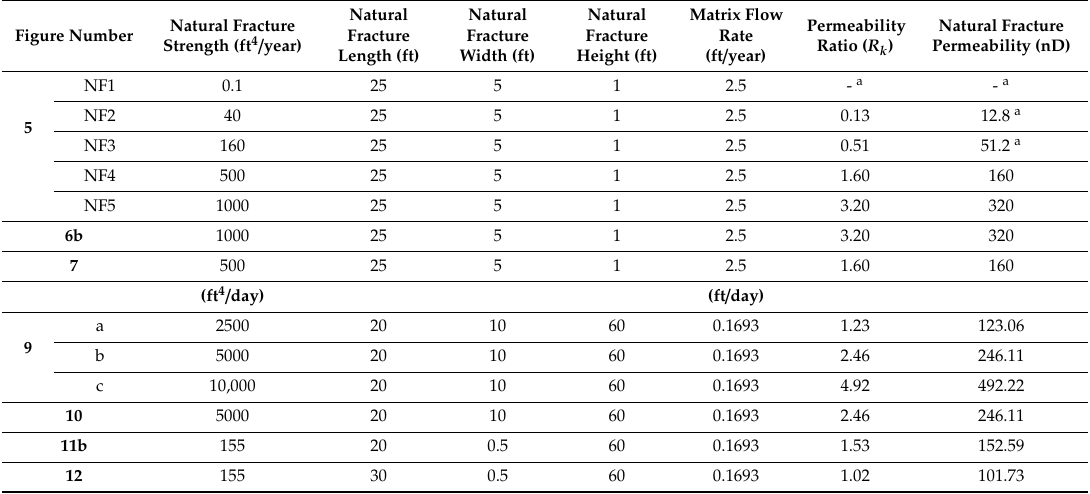
Table 1. List of natural fracture input properties for models with enhanced permeability.